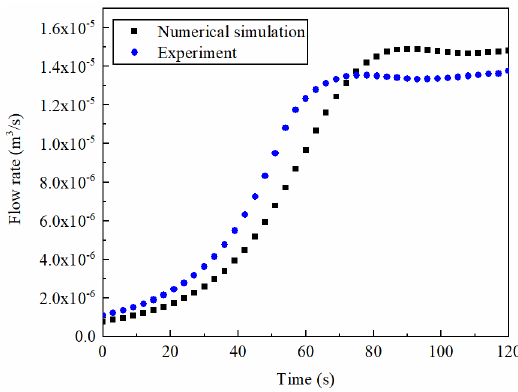
Figure 14. The flow rate curves of numerical simulation versus experiment.